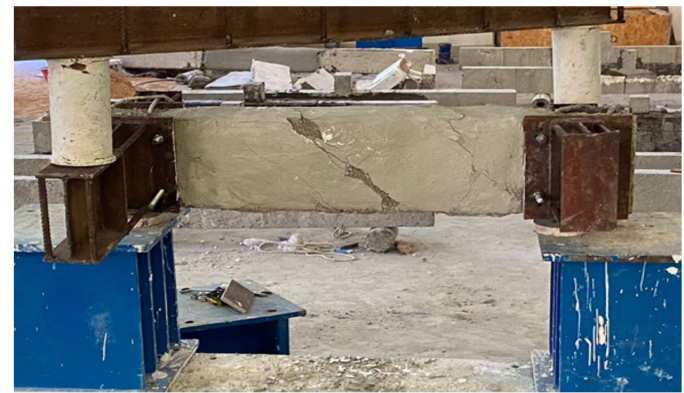
Figure 18. Final crack of beam B3-GFRP.